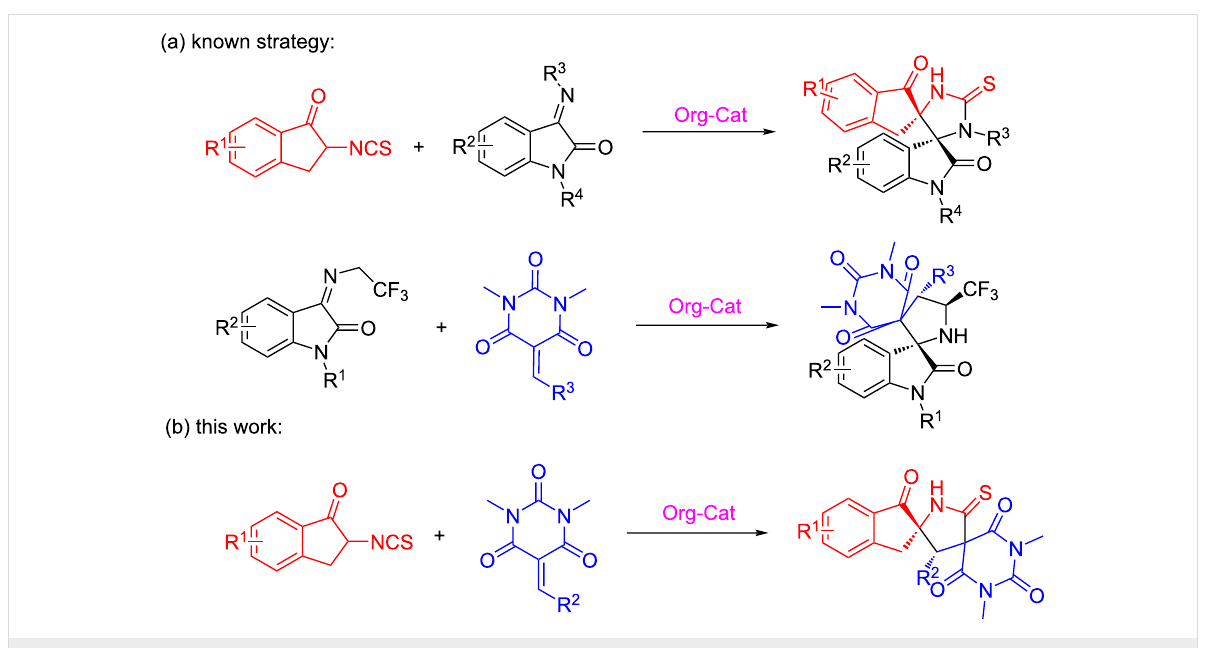
Scheme 1: Known strategies and conceptual advance of this